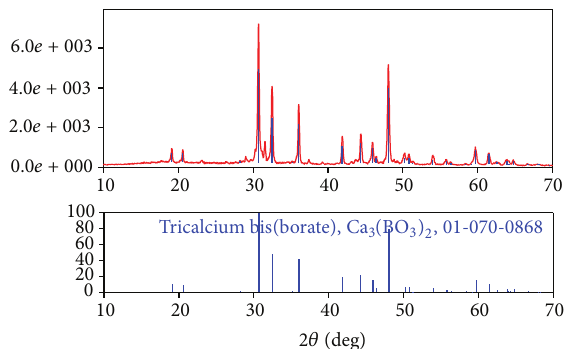
Figure 1: X-ray powder diffraction patterns of Ca 3 (BO 3 ) 2 synthe- sized by solution combustion synthesis.